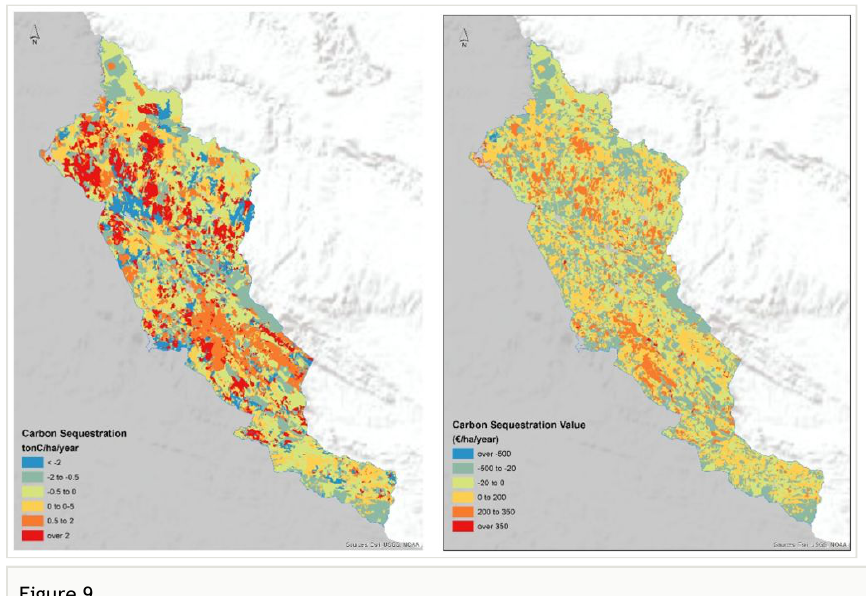
Figure 9. Spatial quanti fi cation (left) and economic valuation (right) of Carbon Sequestration service [ 2.3.5.1 ] within PNSSM.